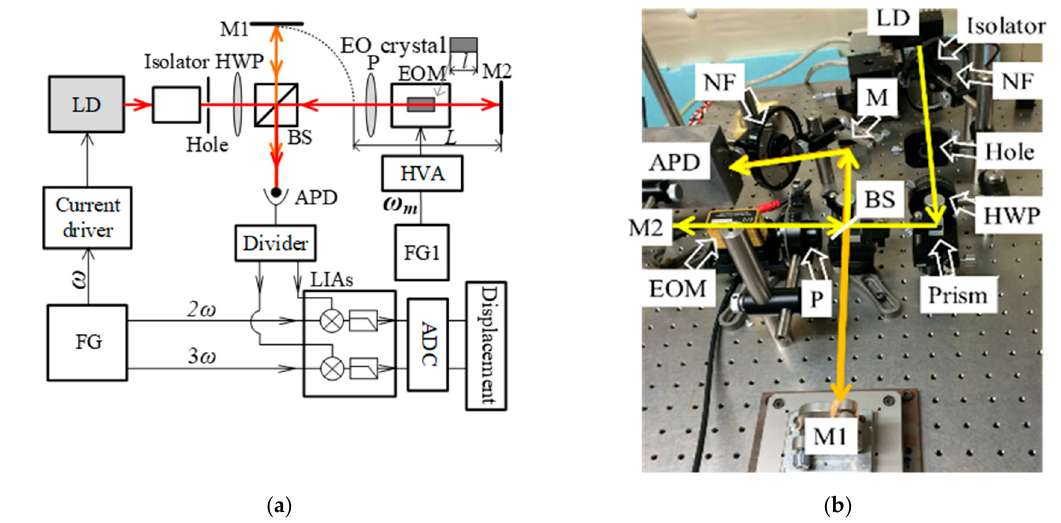
Figure 1. Virtual displacement-measuring interferometer using a frequency-modulated laser source. ( a ) Schematic design and ( b ) the experimental setup. LD: laser diode; HWP: half-wave plate; BS: beam splitter; M: mirror; P: polarizer; EOM: electro-optic modulator; EO crystal: electro-optic crystal; NF: neutral density filter; HVA: high-voltage amplifier; FG: function generator; APD: avalanche photodetector; LIA: lock-in amplifier; ADC: analog-to-digital converter.